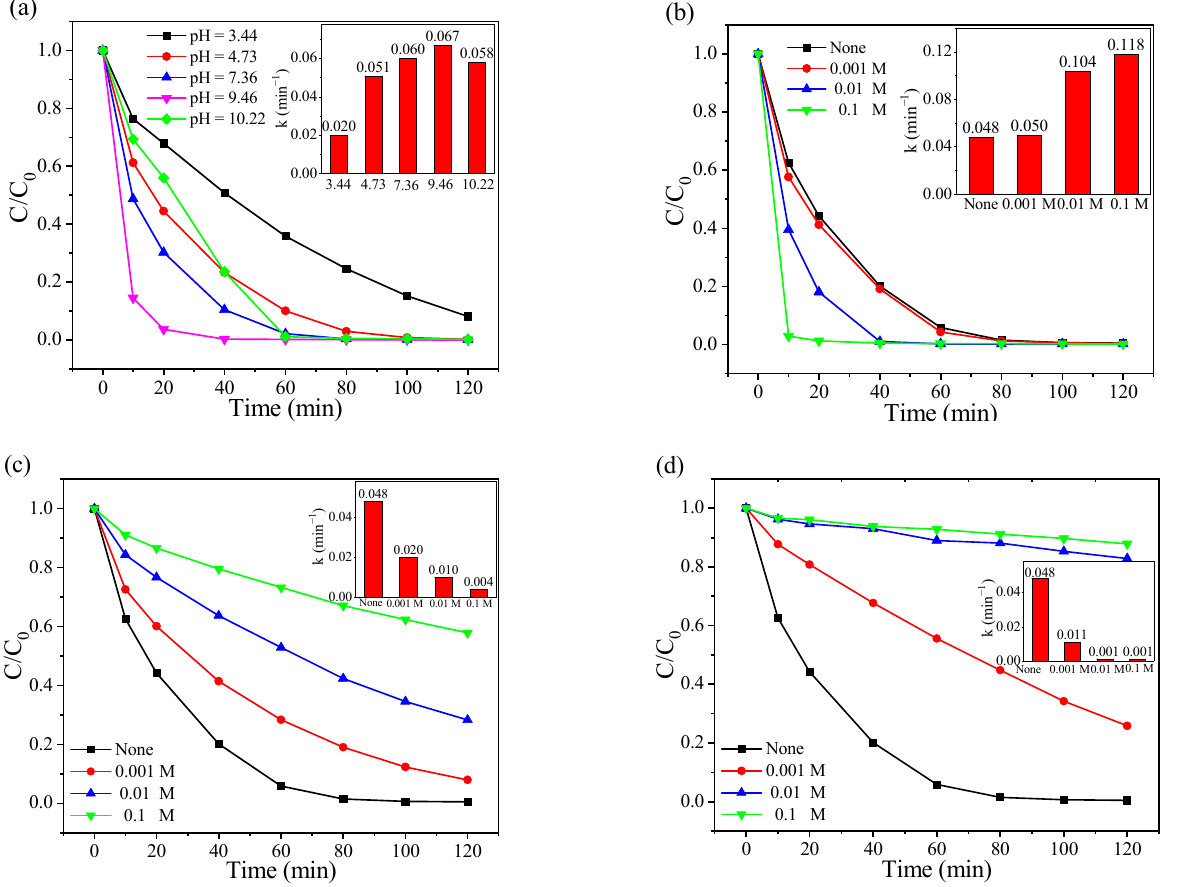
Figure 3. Effects of ( a ) initial pH and different anions ( b ) Cl − , ( c ) HCO 3 − , and ( d ) CO 32 − on RhB degradation and their corresponding pseudo-first-order model kinetic results (inset) in the CoAl 2 O 4 - 500/PMS system.